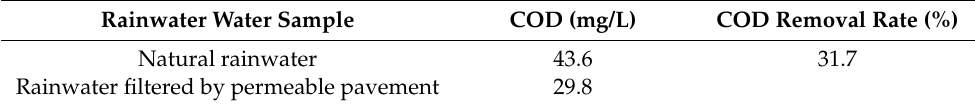
Table 7. COD content in rainwater